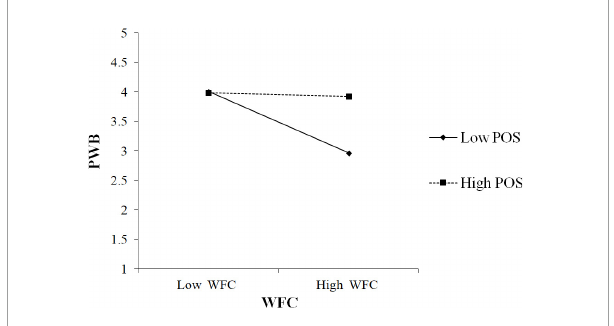
FIGURE2 Effects of work-family conflict (WFC) and perceived organizational support (POS) on psychological wellbeing